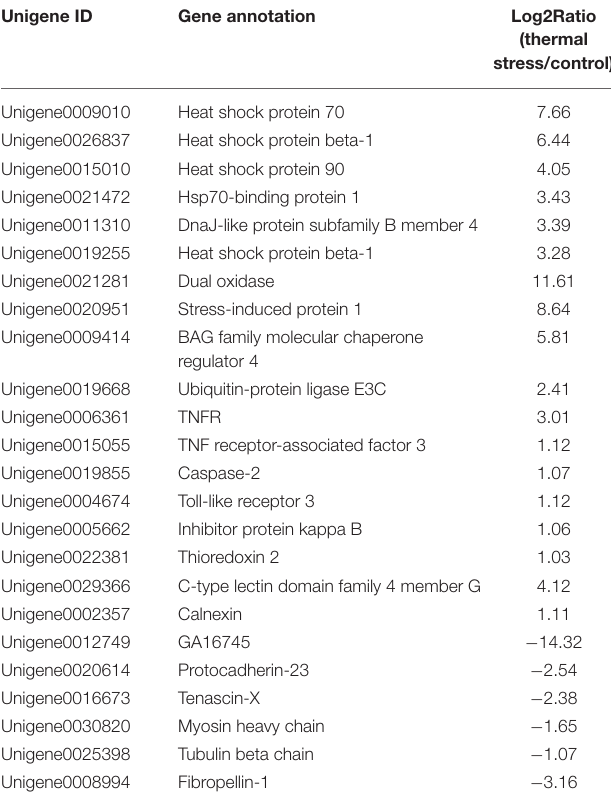
FIGURE 1 | Differentially-expressed genes (DEGs) in thermal stress and control group ( P ≤ 0.05). (A) Scatter plot showing the relationship between the gene expression level in oysters in presence and absence of thermal stress. The red triangles and the green dots represent the up-regulated and down-regulated genes, respectively. The brown dots represent the genes that are not differentially expressed. (B) Number of differentially expressed transcripts based on pairwise comparison: 378 (red) among the 605 differentially expressed genes were up-regulated whereas the rest (green) were down-regulated ( P ≤ 0.05). TABLE 3 | Selected DEGs between the thermal tress and control